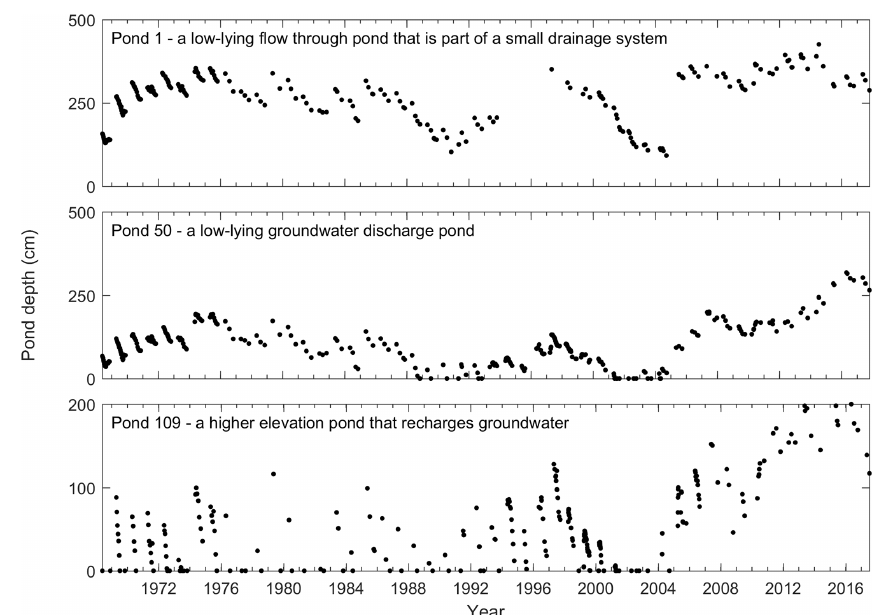
Figure 4. Pond level fluctuations with time in Wetland 1, 50, and 109.